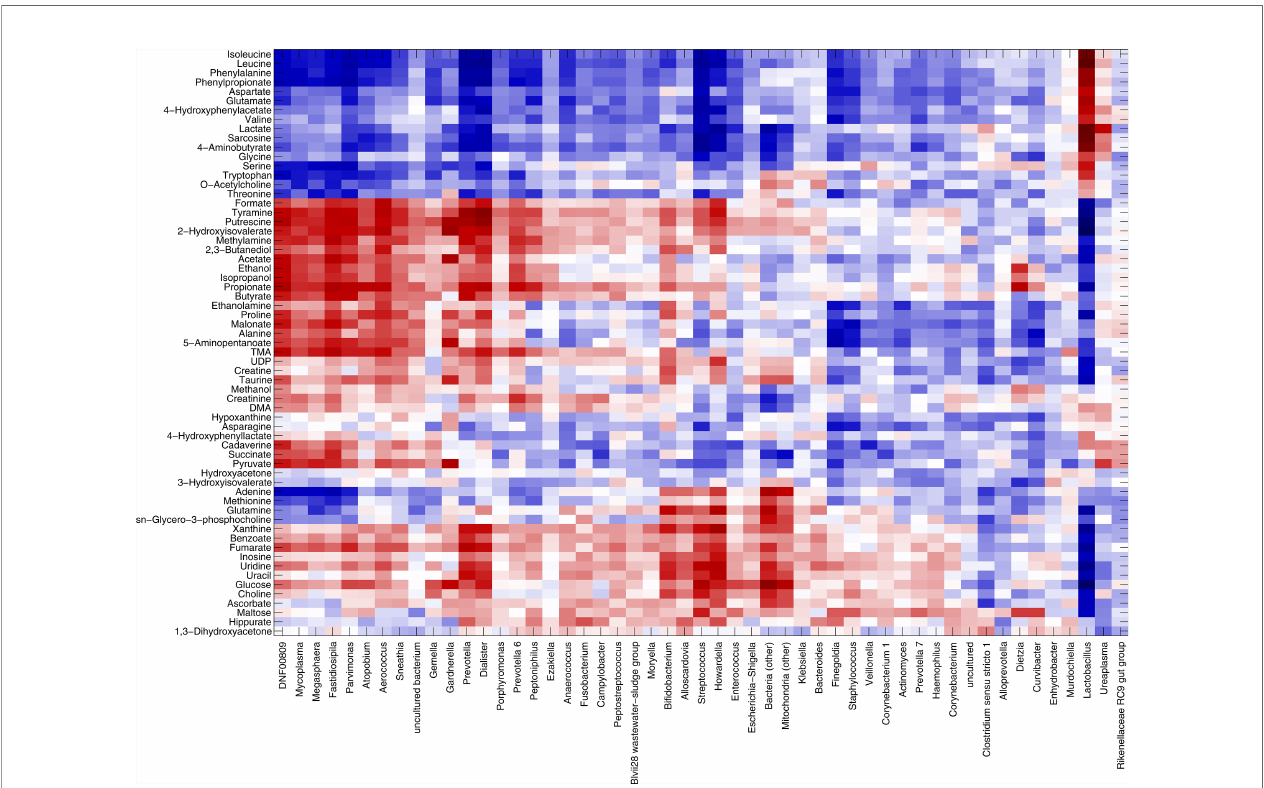
FIGURE 4 | Correlation between metabolome and microbiota. Heatmap showing the Spearman ’ s correlation coef fi cient between metabolites concentration and the relative abundances of the main bacterial genera over all samples collected, excluding miscarriages (n=219). Only groups present at >1% of relative abundance in at least one sample were considered. Metabolite and microbial data were clustered using Pearson ’ s correlation metric and average